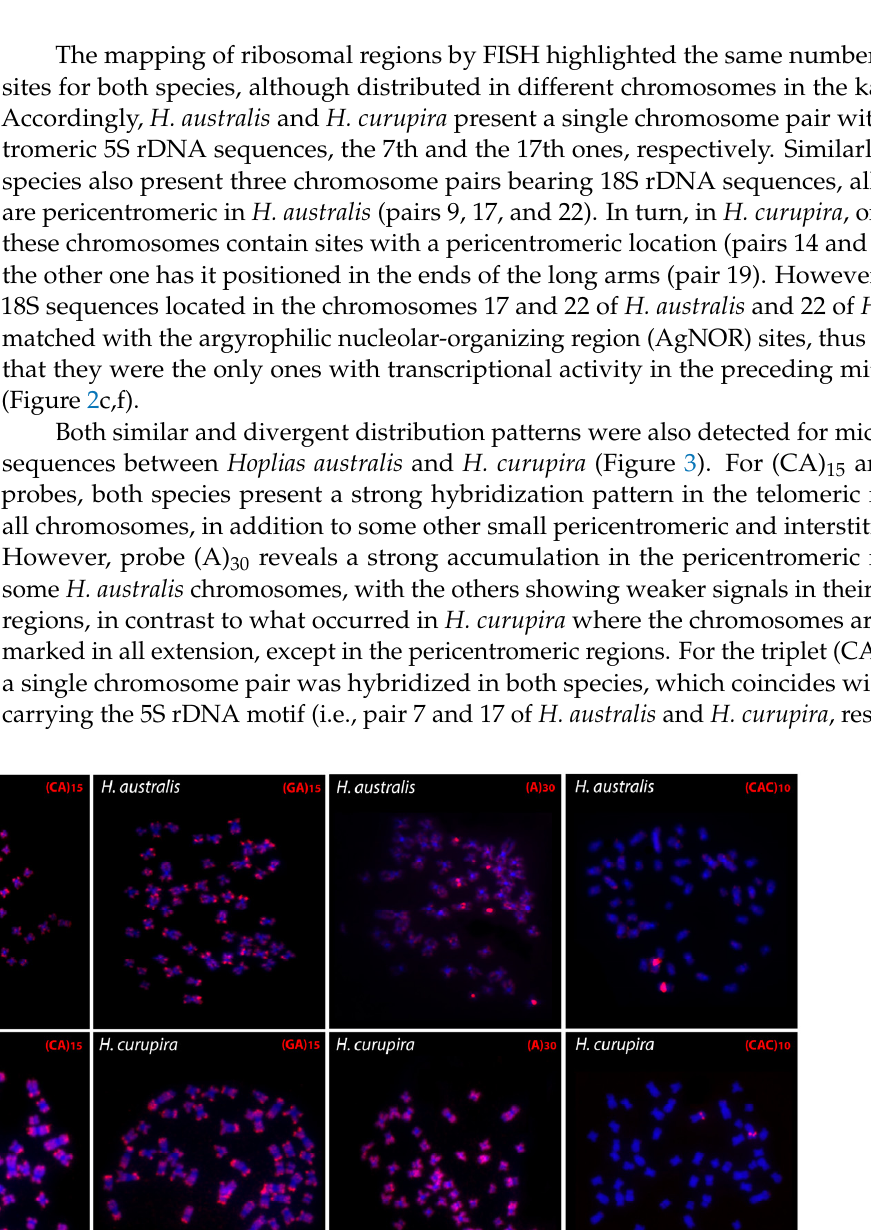
Figure 2. Karyotypes of Hoplias australis ( a – c ) and H. curupira ( d – f ) organized from Giemsa-stained ( a , d ) and C-banded ( b ),( e ) chromosomes. Dual-color fluorescence in situ hybridization (FISH) karyotypes with 5S (red) and 18S (green) rDNA probes are also shown for both species ( c ) and ( f ), respectively, with chromosomes counterstained with DAPI (blue). Scale bar = 5 μ m.